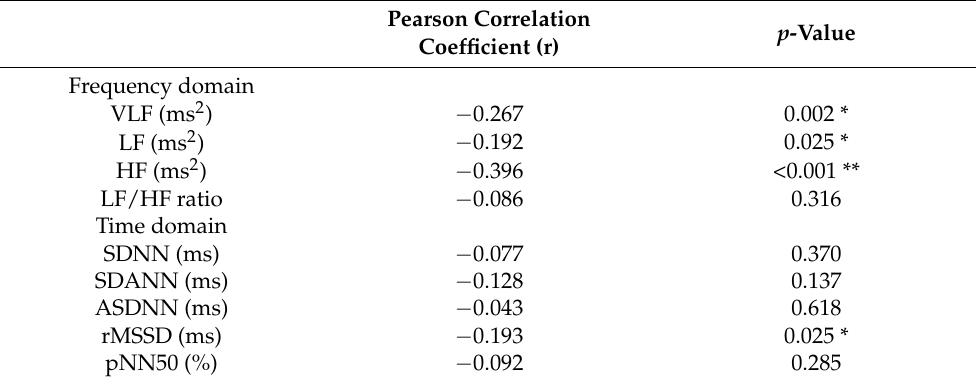
Table 5. Correlation between HRV parameters and the Beck Depression Inventory.